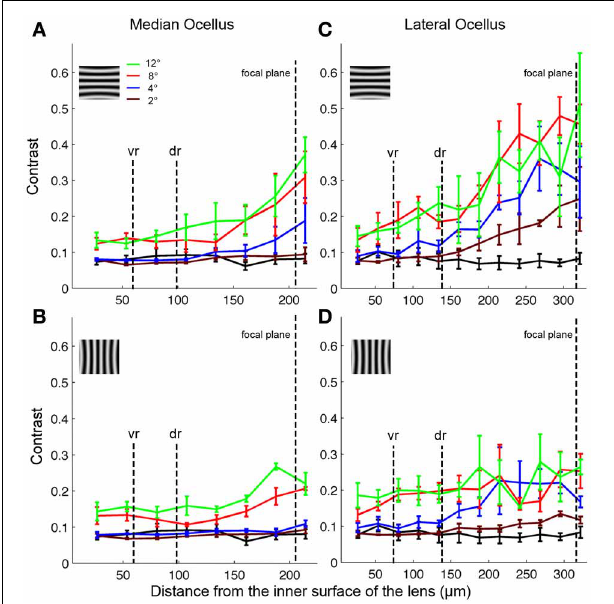
FIGURE 7 | Contrasts of images formed by the honeybee median (A,B) and lateral (C,D) ocellar lenses at different distances in relation to the inner surface of the tested lenses (mean ± SE, n = 3). The different colored lines show results from different spatial wavelengths. The black lines show the contrasts obtained for a blank screen. The focal plane, and the distances of the ventral (vr) and dorsal (dr) retinas are shown by vertical dashed lines. Inserts show the orientation of the gratings in each case (vertical or horizontal).